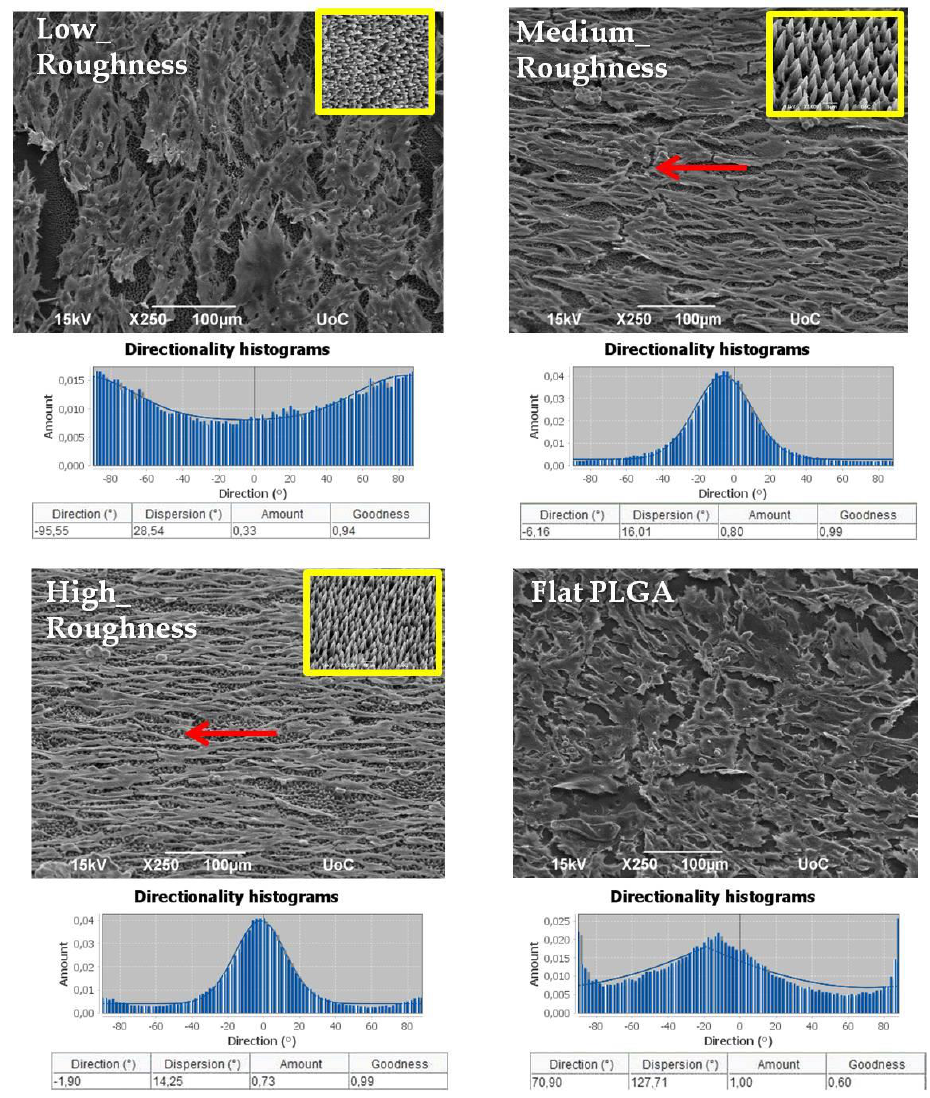
Figure 6. Scanning electron microscopy (SEM) images of Schwann cells cultured on the PLGA-MS replicas (three topographies) and on flat PLGA for 3 days. The red arrows represent the directionality of Schwann cells, which are oriented according to the topography of the PLGA-MS replica (inset SEM image, indicated by the yellow box, on the right side of each group). Under the SEM images, directionality histograms and tables with statistics are presented, which were generated using the Fiji ImageJ plug-in “Directionality” [43]. Above the histogram, the plug-in generates statistics for the highest peak found. The highest peak is fitted by a Gaussian function, taking into account the periodic nature of the histogram. In the tables, the “Direction ( ◦ )” column reports the center of the Gaussian; the “Dispersion ( ◦ )” column reports the standard deviation of the Gaussian; the “Amount” column is the sum of the histogram from center-std to center+std, divided by the total sum of the histogram; the “Goodness” column reports the goodness of the fit, where 1 is good, 0 is